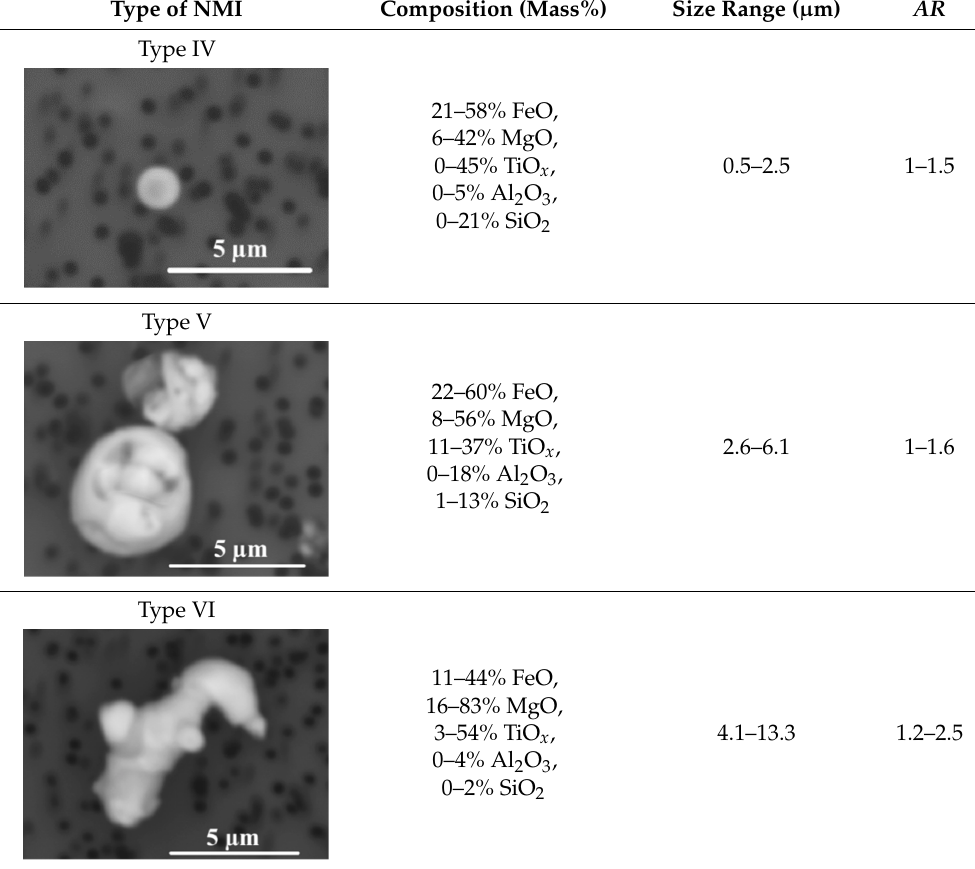
Table 5. Classification of different inclusions observed in the Ti/Mg experiments after electrolytic extraction. Type of NMI